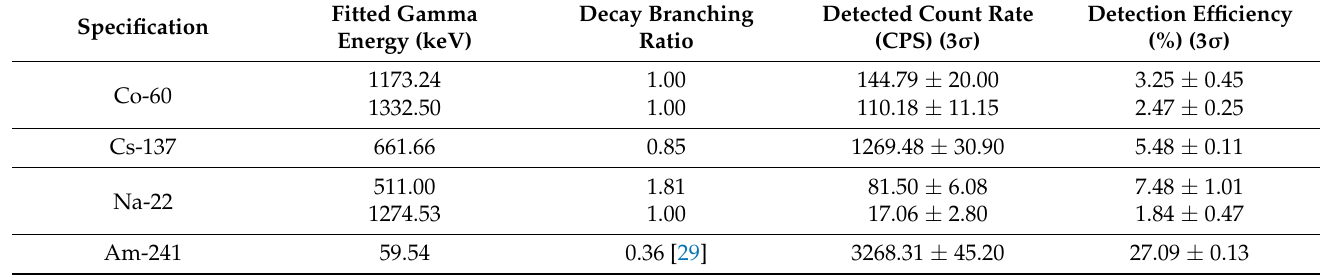
Table 3. Detection efficiency of each gamma peak, with all peak channels adjusted to a zoom of 1.